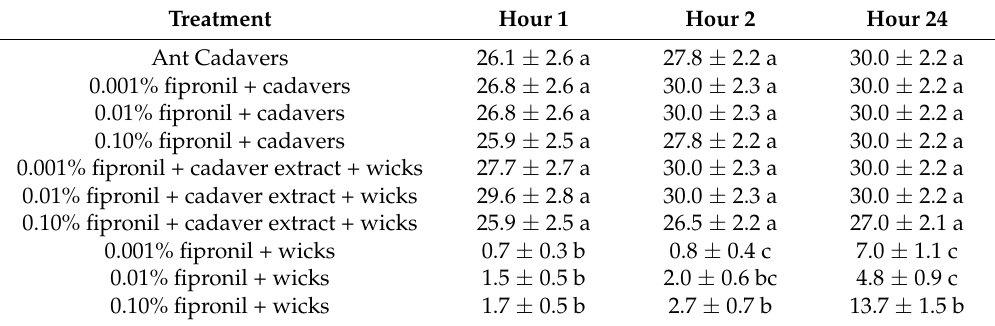
Table 1. Number (mean ± standard error (SE); n = 6 replicates per mean) of fipronil-treated and untreated Argentine ant cadavers and paper wicks ( n = 30) removed at one, two, and 24 h by Argentine ant workers. Means within a column, and followed by the same letter, are not significantly different